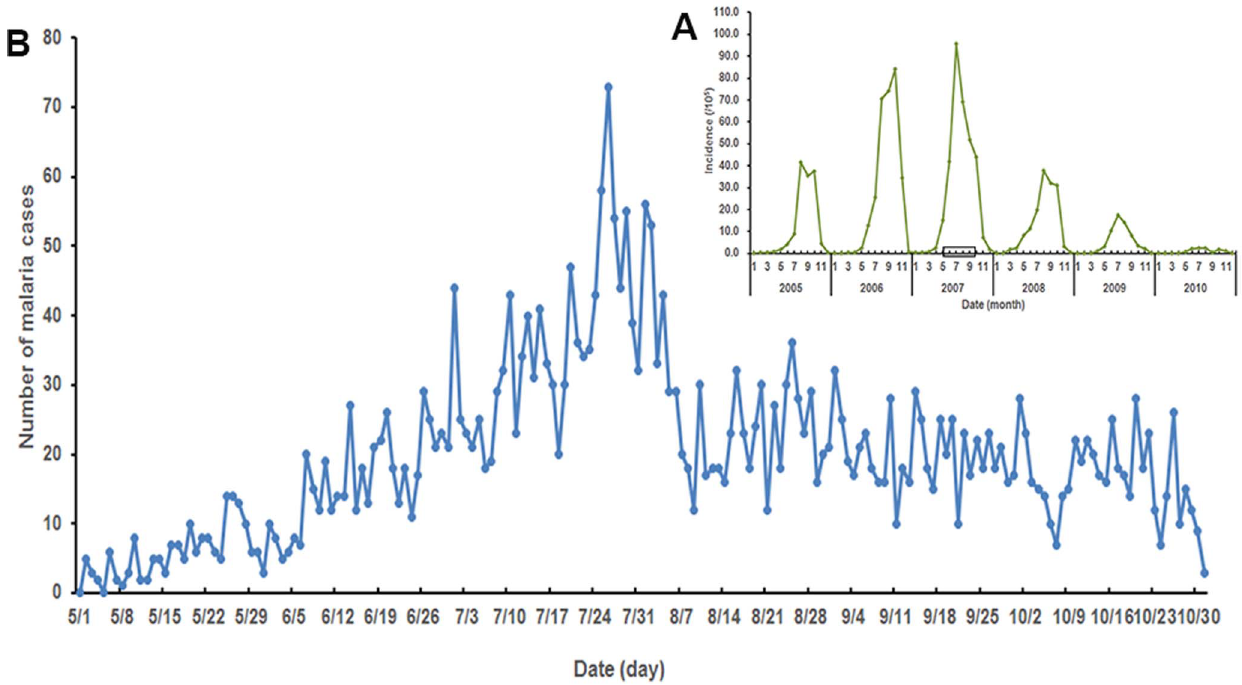
Figure 1. Monthly incidence of malaria from 2005–2010 (A) and daily cases of malaria during the study period (B) in Mengcheng County.